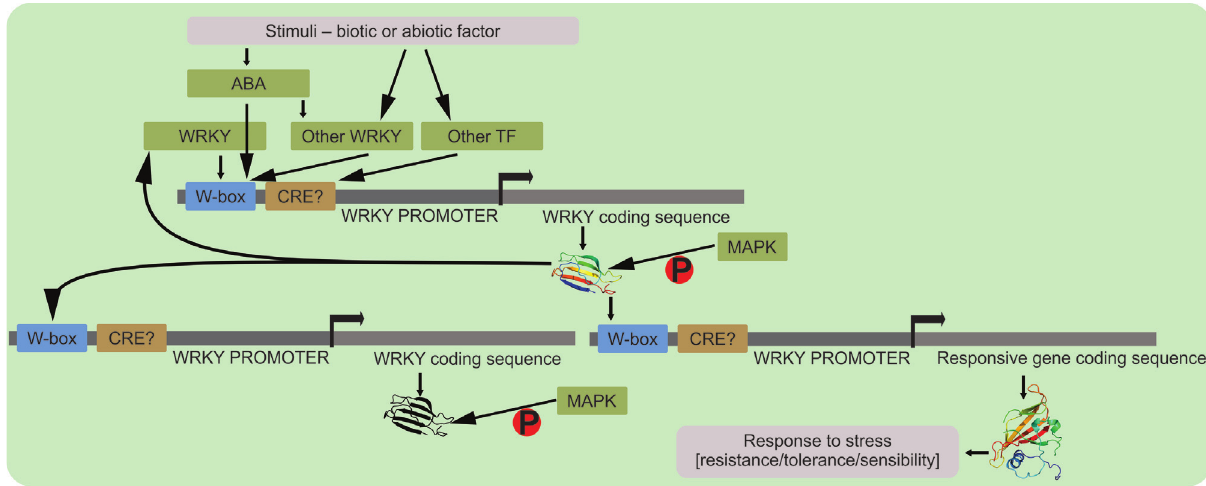
Figure 2 - Regulatory mechanism of WRKY transcription factors. The signaling pathway starts with an environmental stimulus through ABA signaling orby trans -regulation,whichcomprisedirecttranscriptionfactoractivation.The trans regulationcanoccurwithaWRKYmember,incaseofpresenceof a W-box, or with other TFs from different families. An auto-regulation mechanism can occur, or regulation by promoter binding of a different WRKY member. In some cases, the phosphorylation by an MAPK cascade is a determinant process for the correct WRKY protein function. When activated, WRKY TFs can regulate a different WRKY by binding its W-box sequence, or regulate some other responsive gene conferring tolerance, resistance, or sensibility toward the environmental